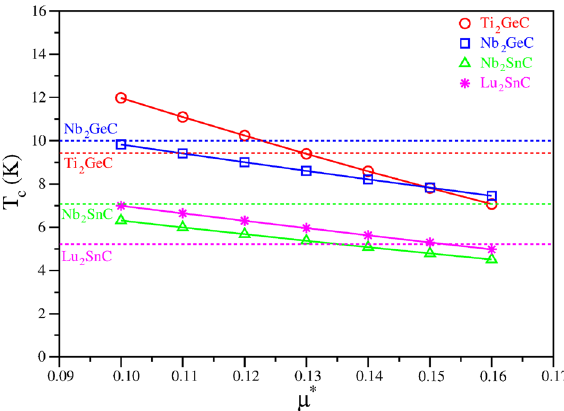
Figure 1. Calculated T c for seven different values of Coulomb repulsion constant ( µ ∗ ). The experimental values of Ti 2 GeC, Nb 2 GeC, Nb 2 SnC and Lu 2 SnC are shown as horizontal red, blue, green and magenta dashed lines,